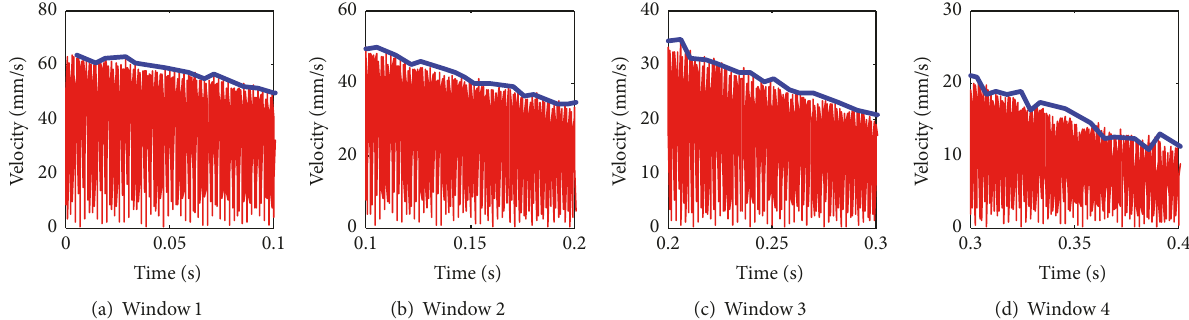
Figure 7: Attenuation envelope-curves of the 3rd damping under different sliding-windows obtained by sliding-envelope method. Table 5: The setting parameters used in random vibration response measurement when the total root mean square value is 0.45 g. Order